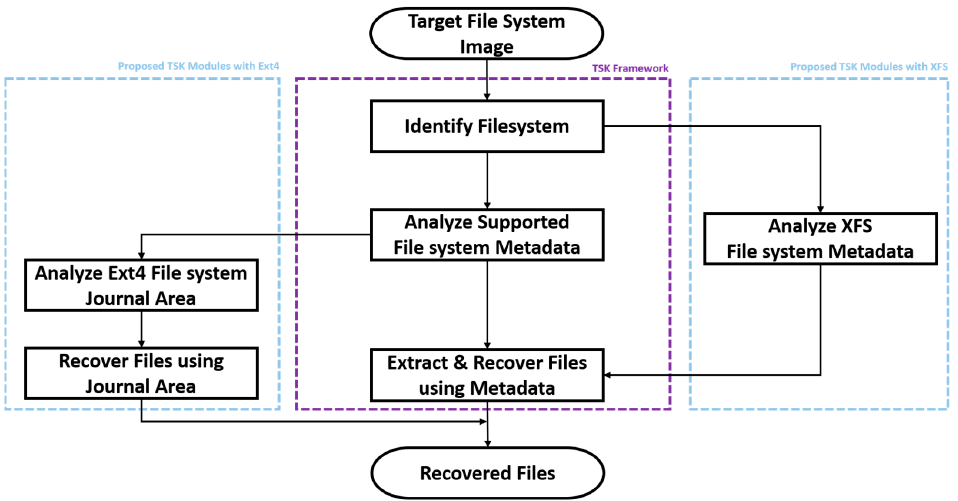
Figure 1. Ext4/XFS file system file recovery framework based on TSK.